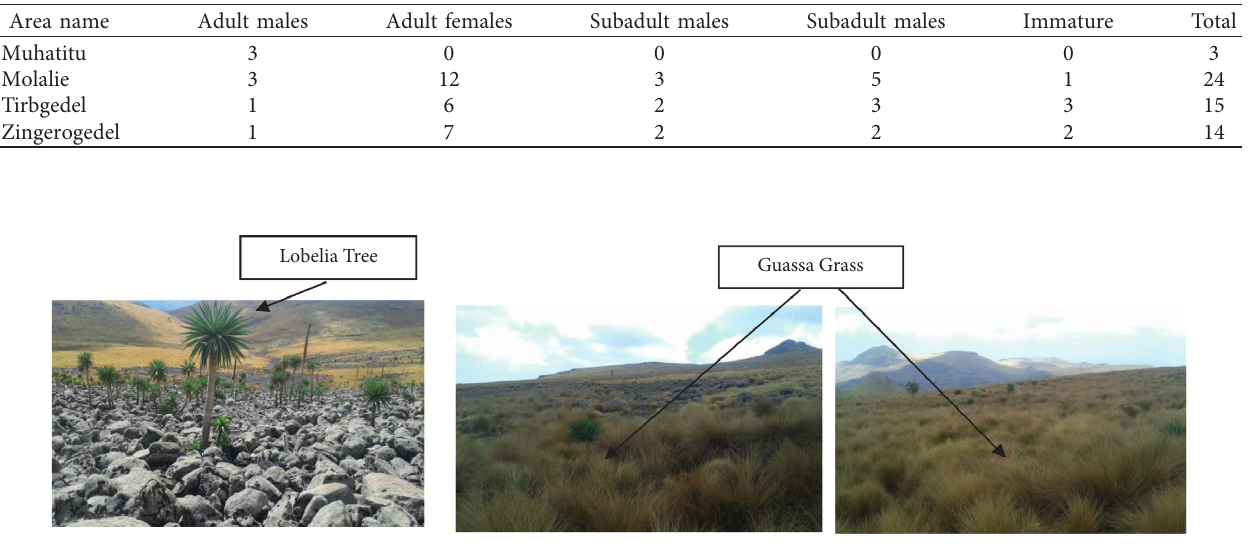
Figure 2: Mount Guna Community Conservation Area (photos captured by the author).